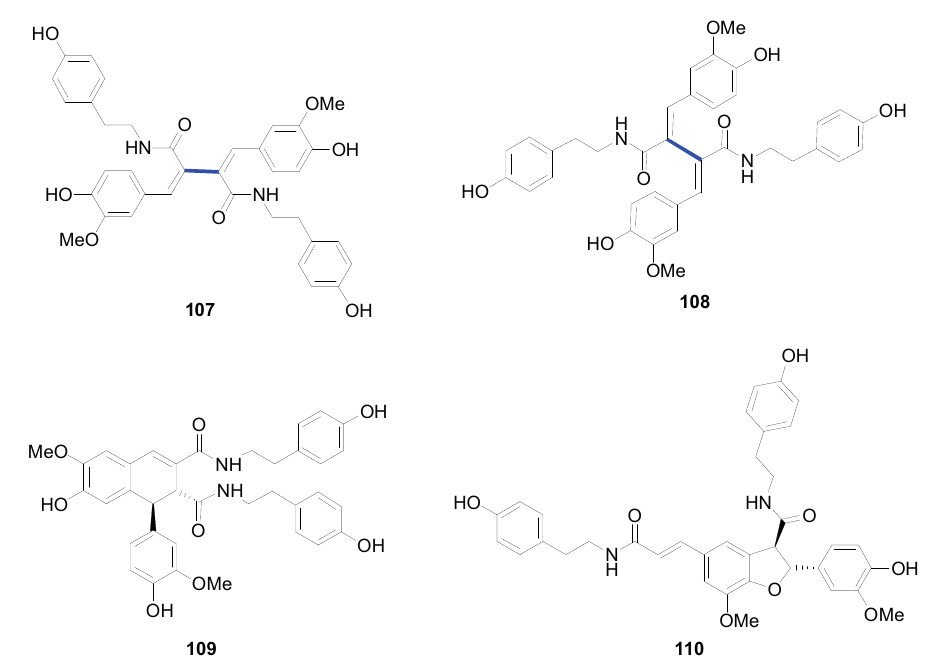
Figure 4. Structures of lignanamides from seeds of Hyoscyamus niger